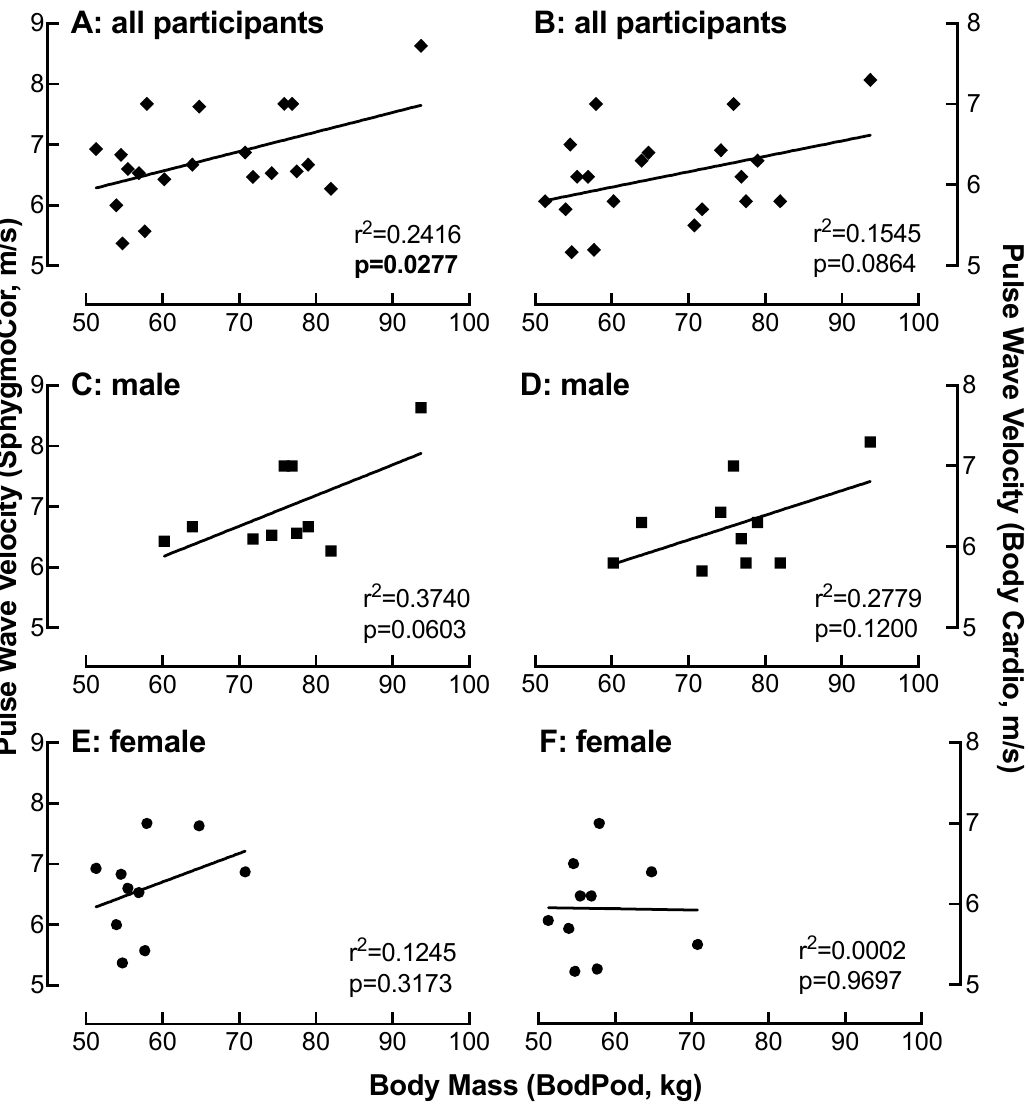
Figure 7. Relationship of BM measured on the Bod Pod with PWV as a function of device. Comparison of BM with PWV measured on the SphygmoCor ( A , C , E ) or the Body Cardio ( B , D , F ) in all participants ( diamond ) ( A , B ) or specifically in the male ( square ) ( C , D ) or female ( circle ) ( E , F ) population. Each data point represents duplicate or triplicate measures in one study participant.